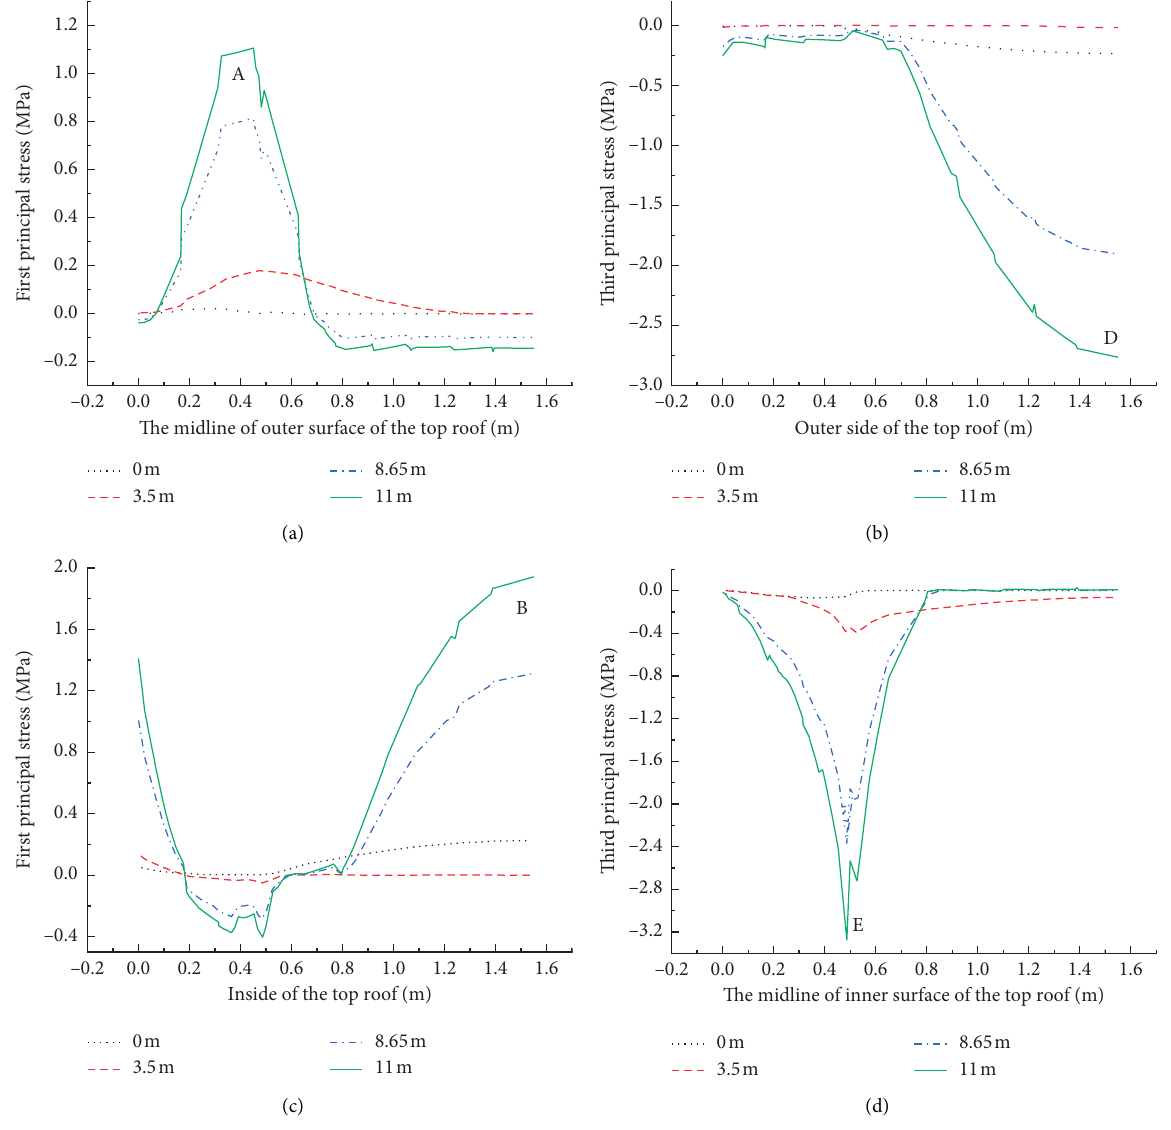
Figure 8: Principal stress variation curve of concrete on the midline of the roof. (a) First principal stress on the outer surface of the roof. (b) Third principal stress on the outer surface of the roof. (c) First principal stress on the inner surface of the roof. (d) Third principal stress on the inner surface of the